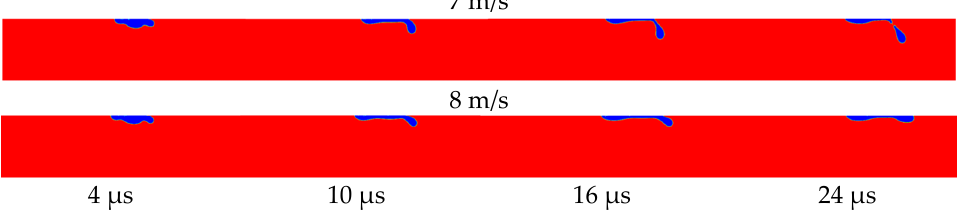
Figure 14. Dynamic evolution diagram of droplet impact process.